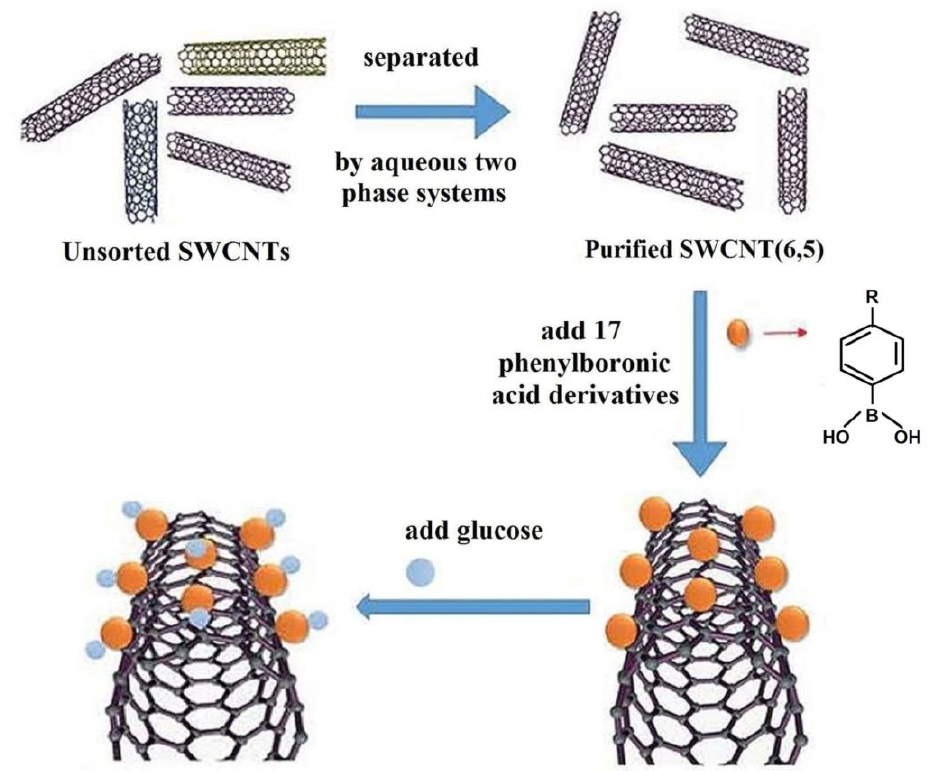
Figure 12. Illustration of SWCNTs preparation and glucose-sensitive complex formation. (Reprinted from reference [98] with permission from the Royal Society of Chemistry).